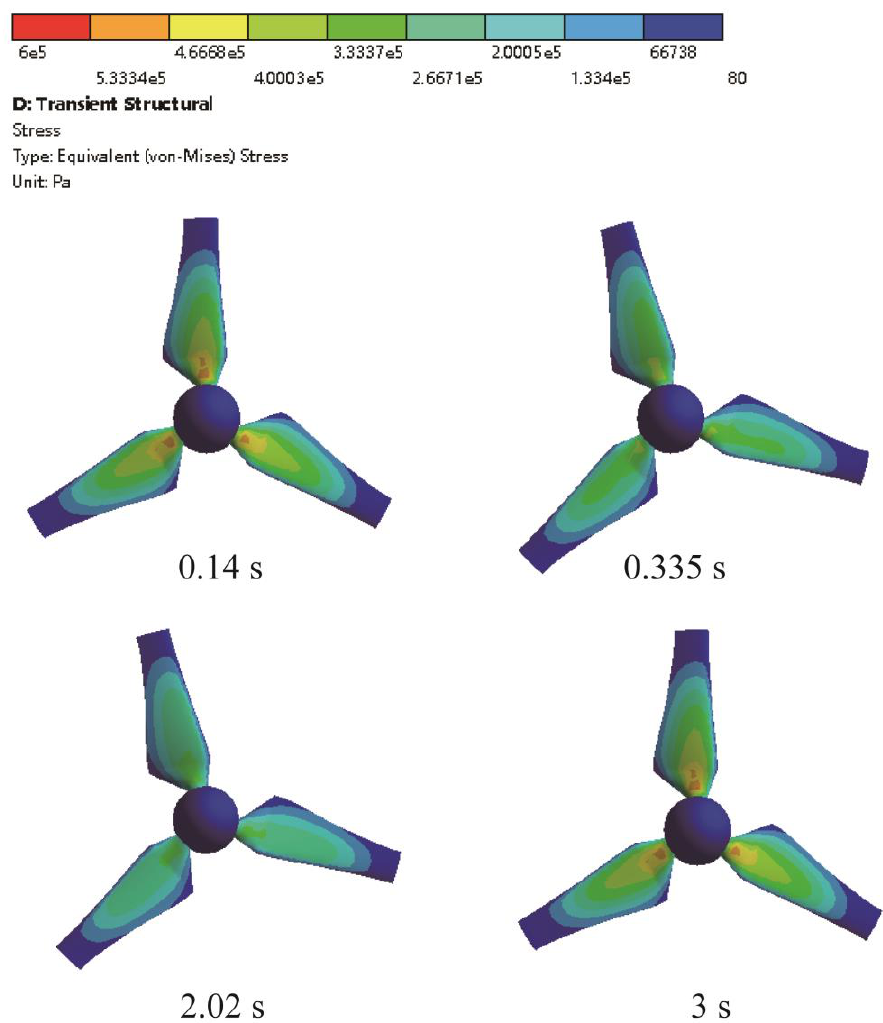
Figure 8. Distribution of blade ’s dynamic stress at different times (Pa).